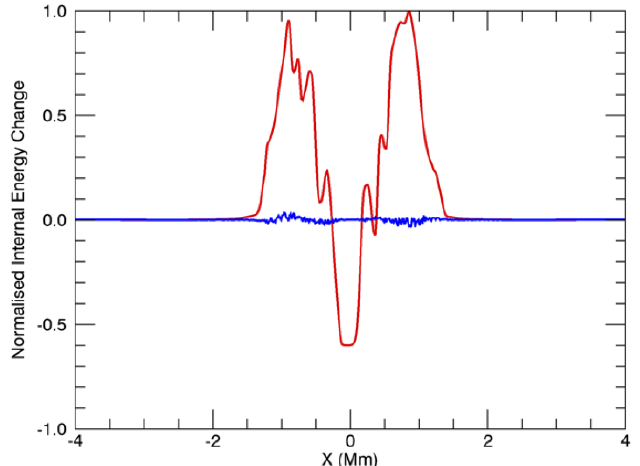
Figure 6. Contribution of the adiabatic effects (blue line) and ρ D (cid:101) /D t (red line) in the energy (red line) in the energy Equation (3). The total contribution over the duration of the ResUni simulation is shown in the line y = 0 Mm, z = 100 Mm. The curves are normalised to the maximum of the red line. See text for